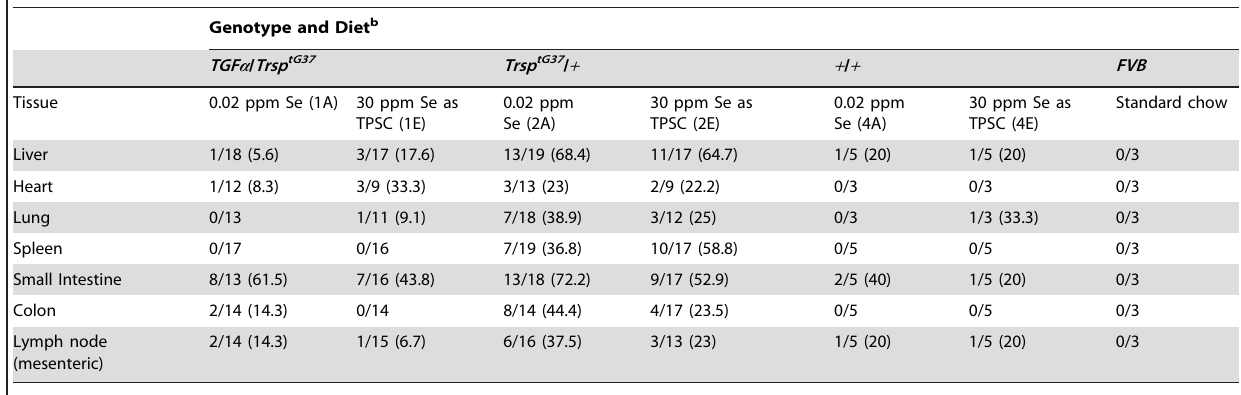
Table 2. Multi-organ pyogranulomatous/granulomatous inflammation a